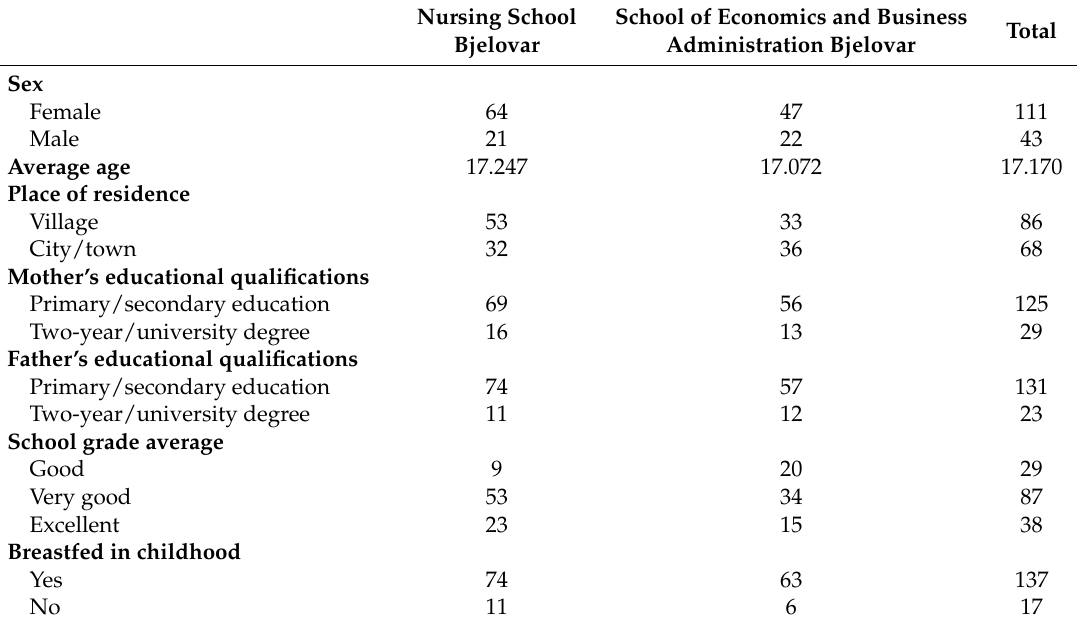
Table 1. Socio-demographic characteristics of the